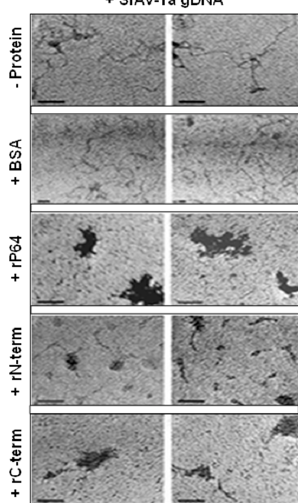
Figure 3. Examples of transmission electron micrographs demonstrating that rP64 and it rC-terminal domain (rC-term) alone precipitate and condense SfAV-1a genomic (g)DNA in vitro. Significantly less extensive precipitation and condensation occurred with the rN-terminal (rN-term) domain of P64. Controls included gDNA without protein (-protein) or with bovine serum albumin (BSA). Bar = 50